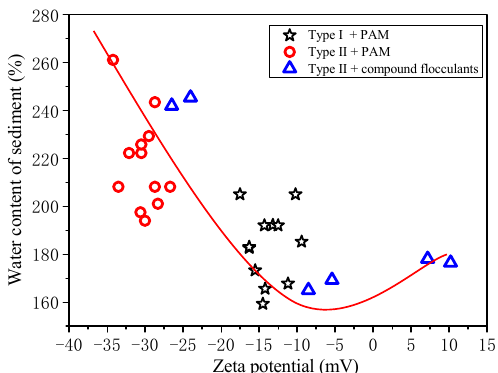
Figure 11. Relationship between water content of sediment and zeta potential.